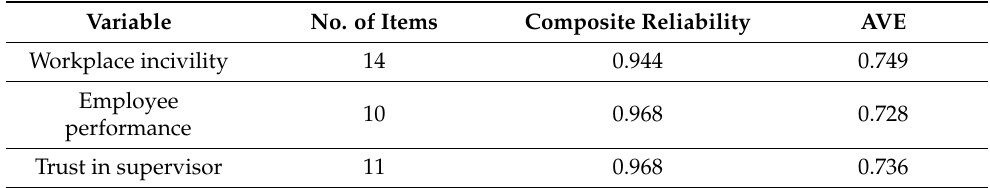
Table 2. Reliability and AVE of the scales.